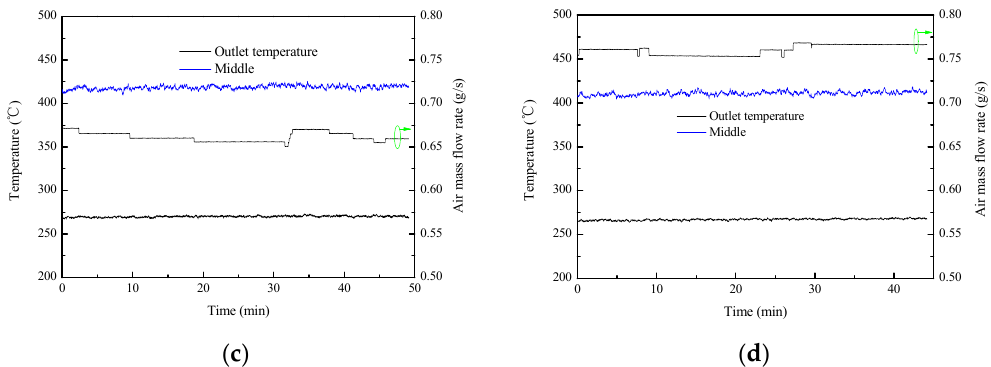
Figure 5. The fluidized heat absorption inside the metal tube. ( a )Case 1; ( b ) Case 2; ( c ) Case 3; ( d ) Case 4.